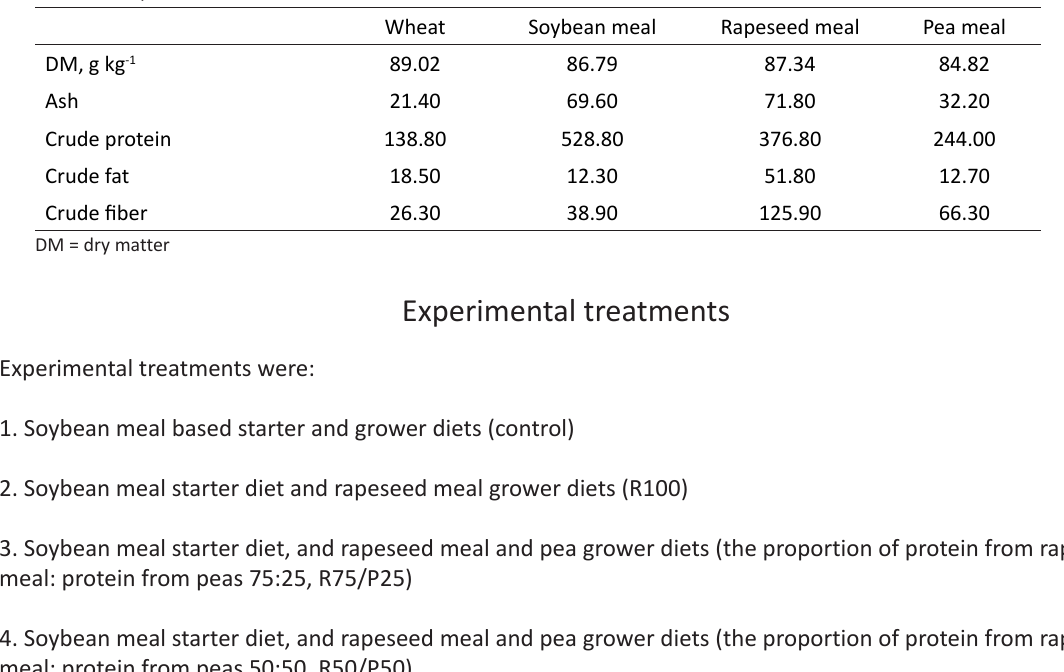
Table 3. The analysed composition (g kg -1 DM, except DM) of wheat, soybean meal, rapeseed meal and pea meal used for experimental